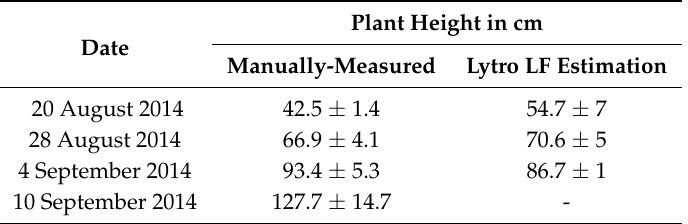
Table 2. Manually-measured plant heights in comparison with the automated estimation of the Lytro